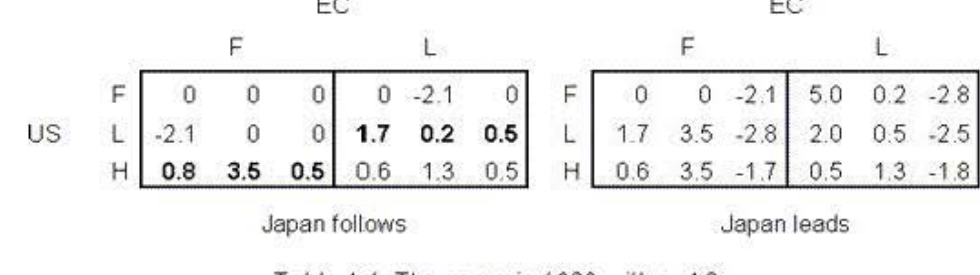
Table 4. 1 The game in 1960 with